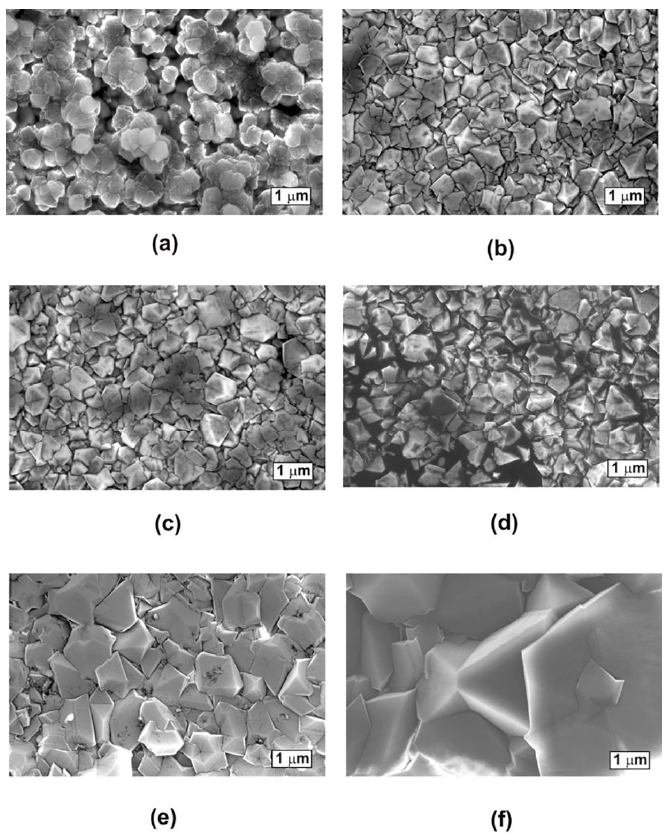
Figure 8. SEM images of diamond films deposited at different temperatures and distances between the substrate and plate holder surfaces: ( a ) Δh = −1 mm, T = 700 °C, half of the radius; ( b ) Δh = 0 mm, T = 740 °C, center; ( c ) Δh = 0 mm, T = 740 °C, half of the radius; ( d ) Δh = 0 mm, T = 740 °C, periphery; ( e ) Δh = 1 mm, T = 760 °C, half of the radius; and ( f ) Δh = 2 mm, T = 870 °C, half of the radius. Micrographs ( a , e , f ) relate to the second CVD series, and micrographs ( b – d ) relate to the third CVD series [17]. This solution allowed it to preserve the nuclei of diamond particles from burning out and significantly increased their density to ~10 9 cm −2 or more. The multi-layer coatings were successive layers of micro- and nanocrystalline diamonds. The synthesis of micro- crystalline layers was carried out without the addition of nitrogen. The concentration of N 2 in the total gas flow was maintained at the level of 4% during the deposition of nano- crystalline layers. According to RAMAN spectroscopy data [20], an intermediate layer with a high concentration of the sp 2 phase does not form at the boundary of the micro-